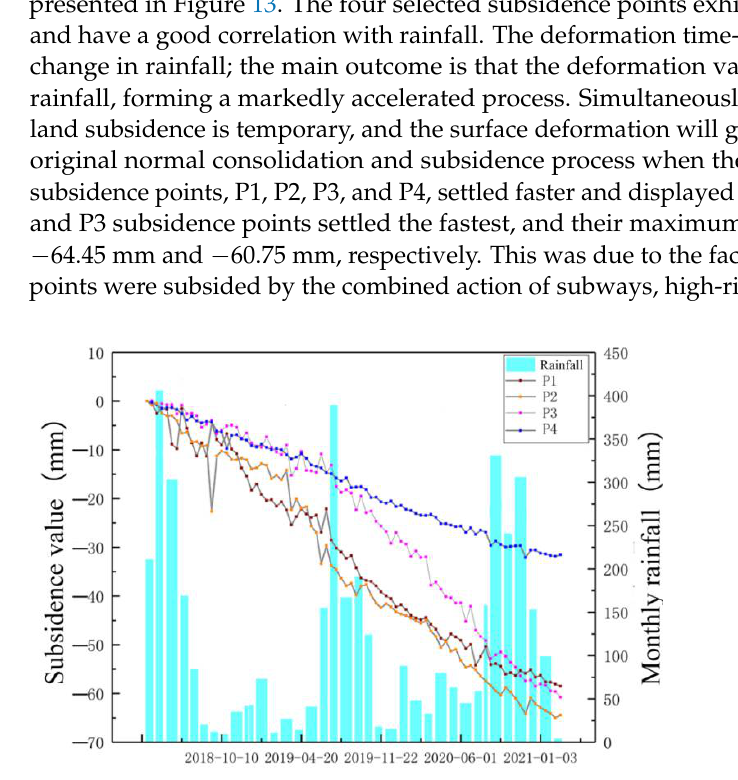
Figure 13. Analysis of the relationship between rainfall and surface